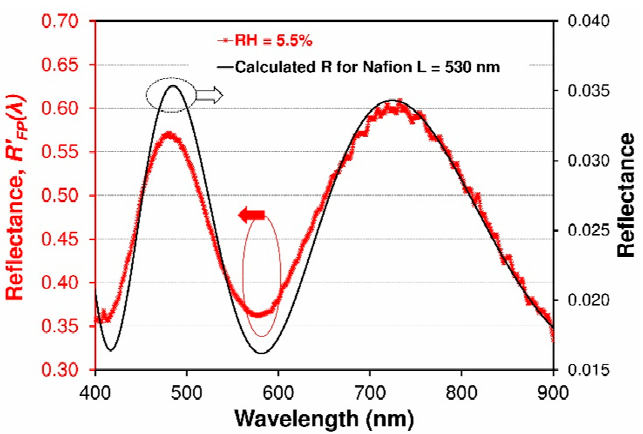
Figure 7. A comparison between measured normalized reflectance spectra ( R FP ’( λ )—red line) of the FPI sensor and a simulation (black solid line) of reflectance spectra with Nafion ® of 726 µ m. Fringe patterns correlating to effective cavity length to nL , where L = 530 nm, n = 1.37 RIU.